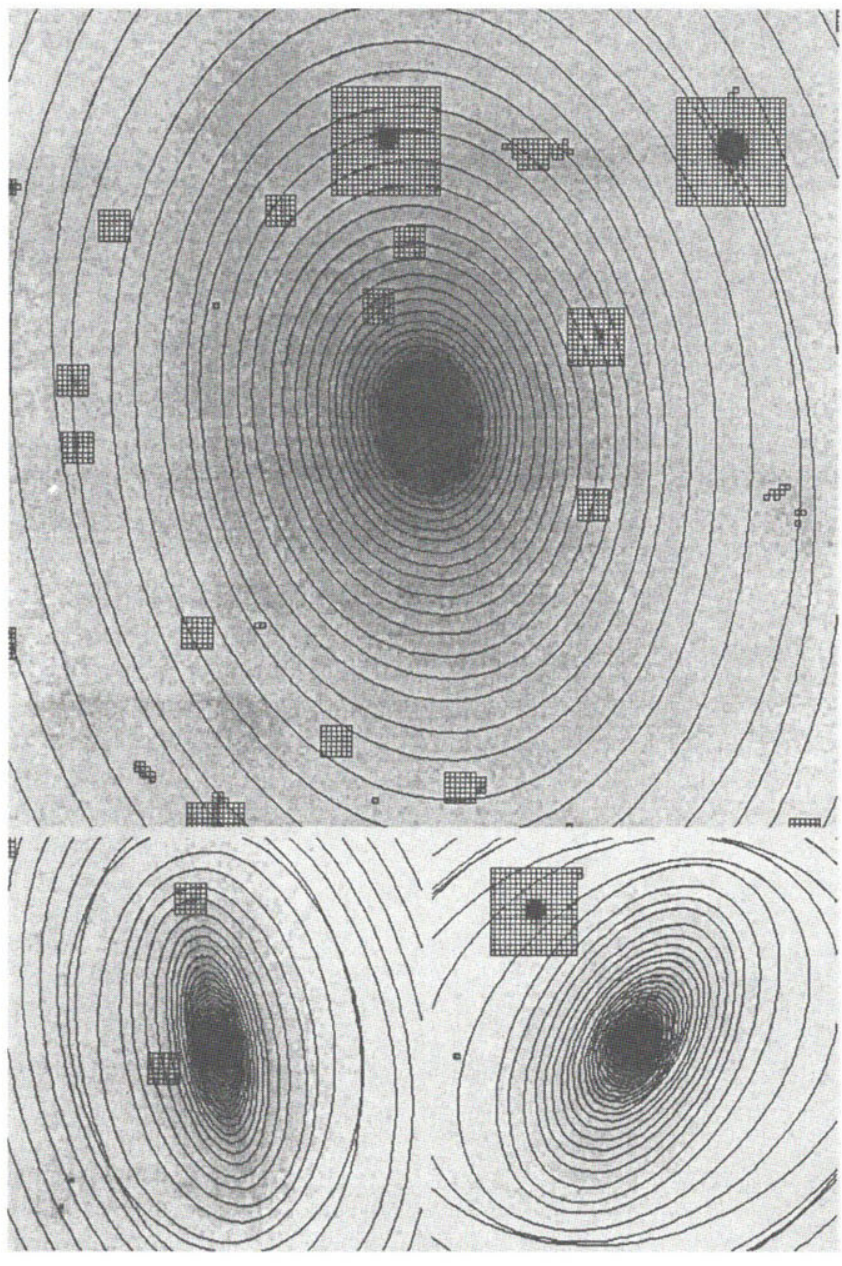
Fig. 2. The three example galaxies, with best-fitting ellipses, and with pixels contaminated by other objects flagged (the hatched